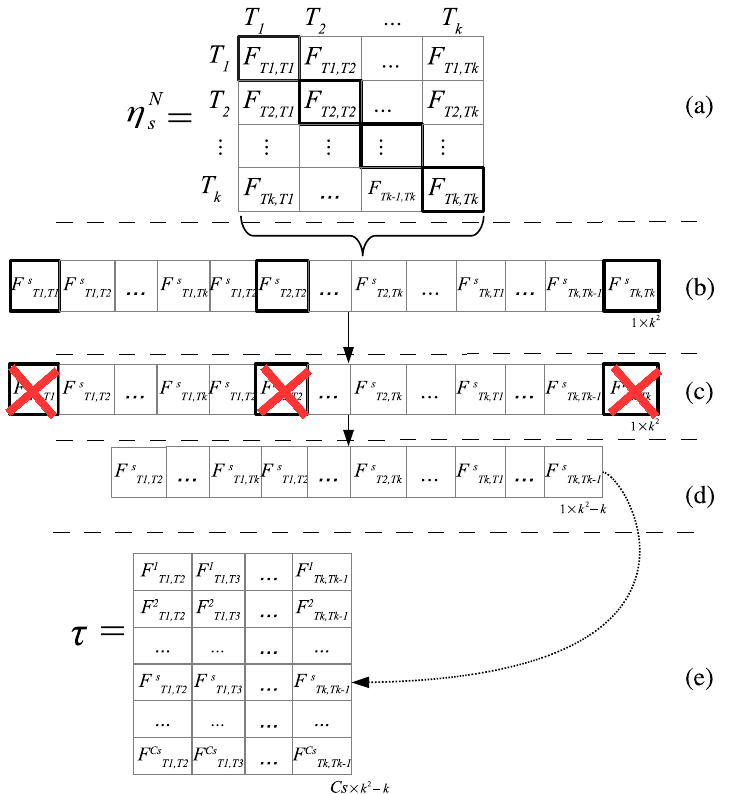
Figure 8. The τ matrix generation process, for every s − th row ∈ τ